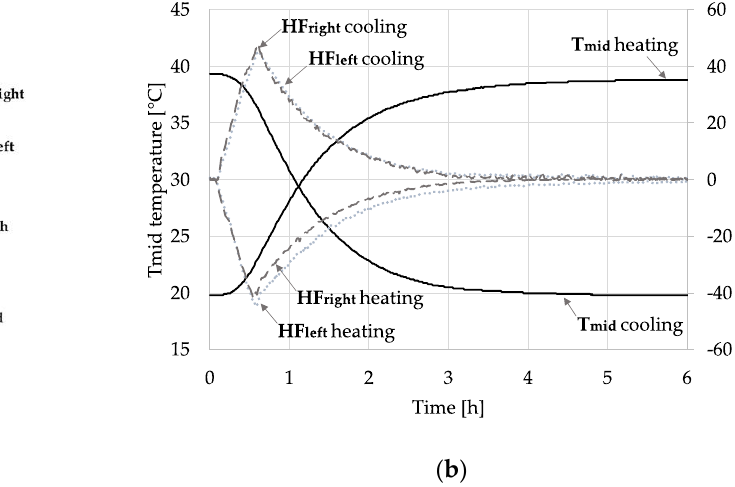
Figure 3. ( a ) Portion of the set up realized to estimate the specific heat of the masonry tile. ( b ) Data collected during the test inside the climatic chamber.